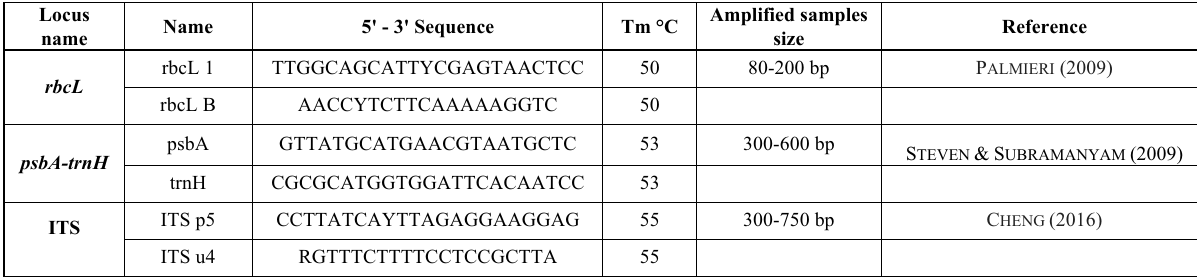
Table A.1: List of primer pairs used for DNA barcoding analysis.